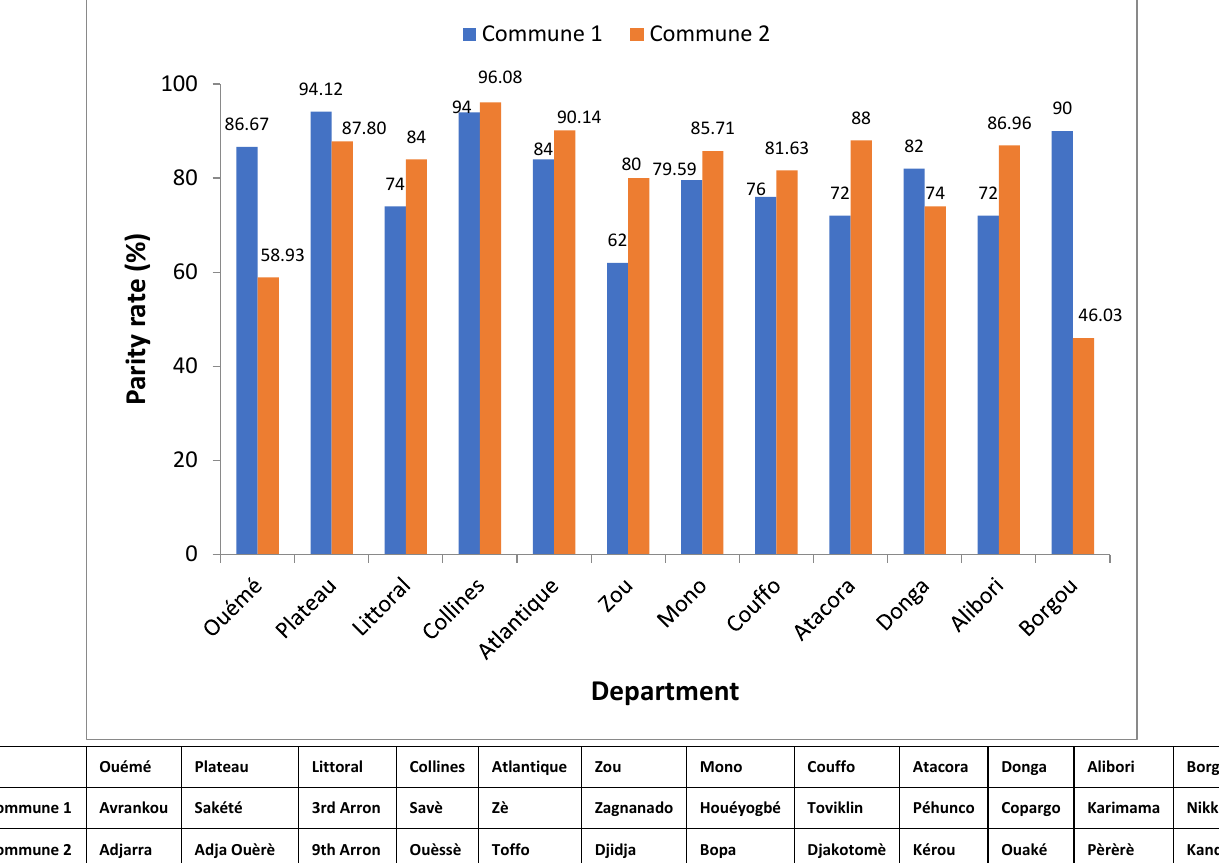
Figure 5. Parity rate of An. gambiae s.l., An. funestus group and An. nili group.